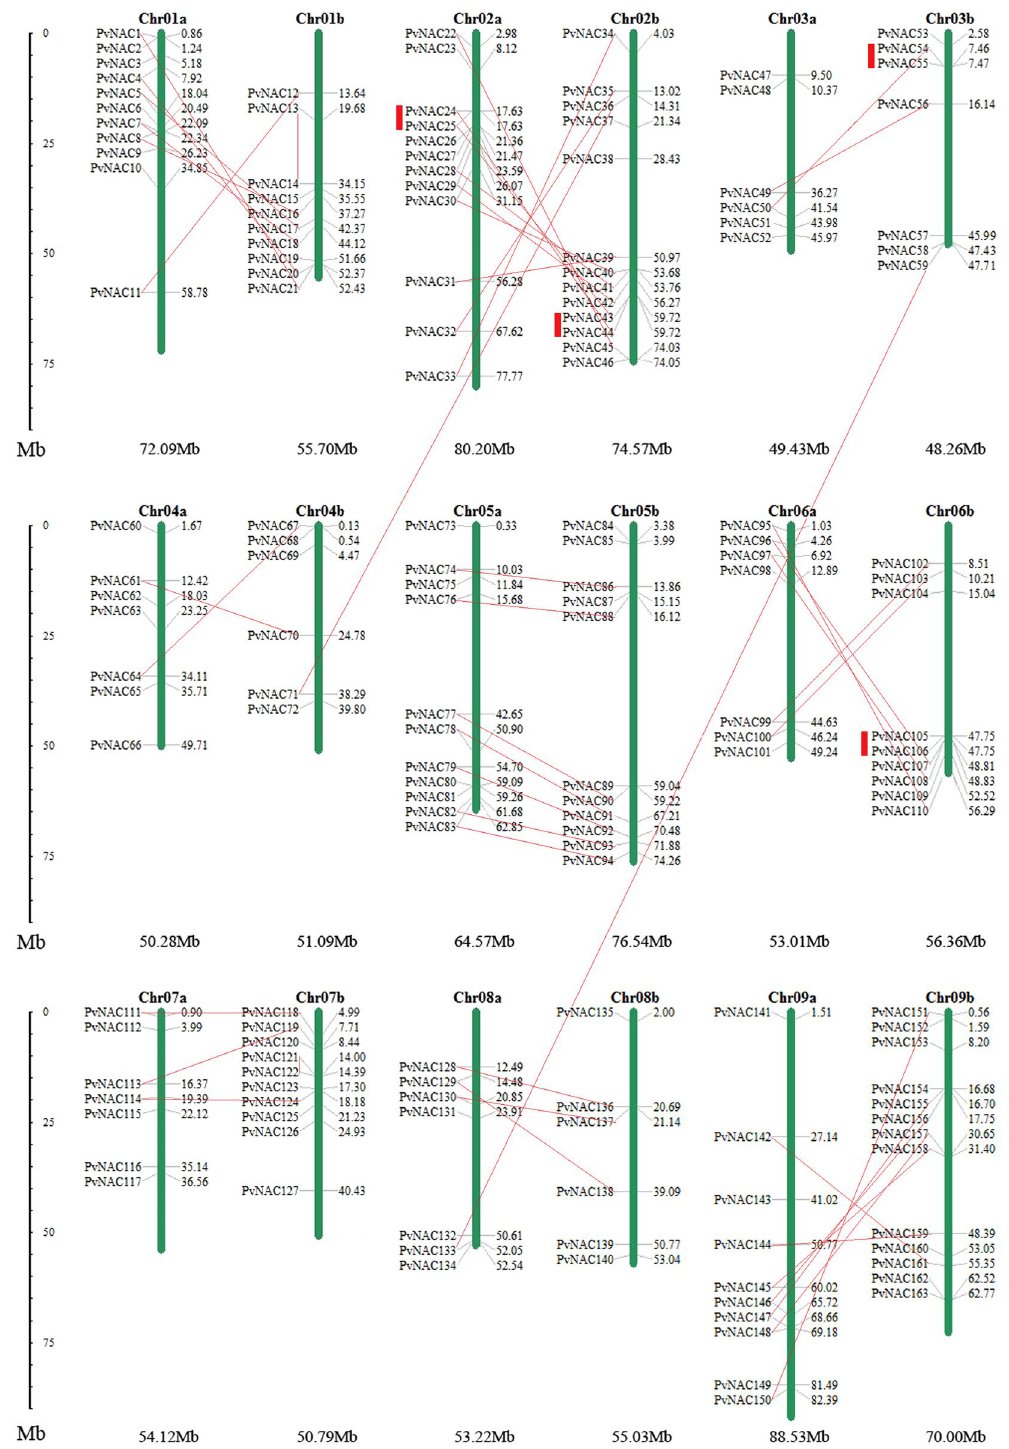
Figure 3. Chromosomal locations of 163 PvNAC s. Duplications generated by allotetraploidy were connected by full lines, while tandem duplications were connected by thick red lines. The numbers listed along each chromosome were locations of PvNAC s, and the smaller/larger number indicated the PvNAC s were closer to start/end point of chromosome. The number below each chromosome was the whole